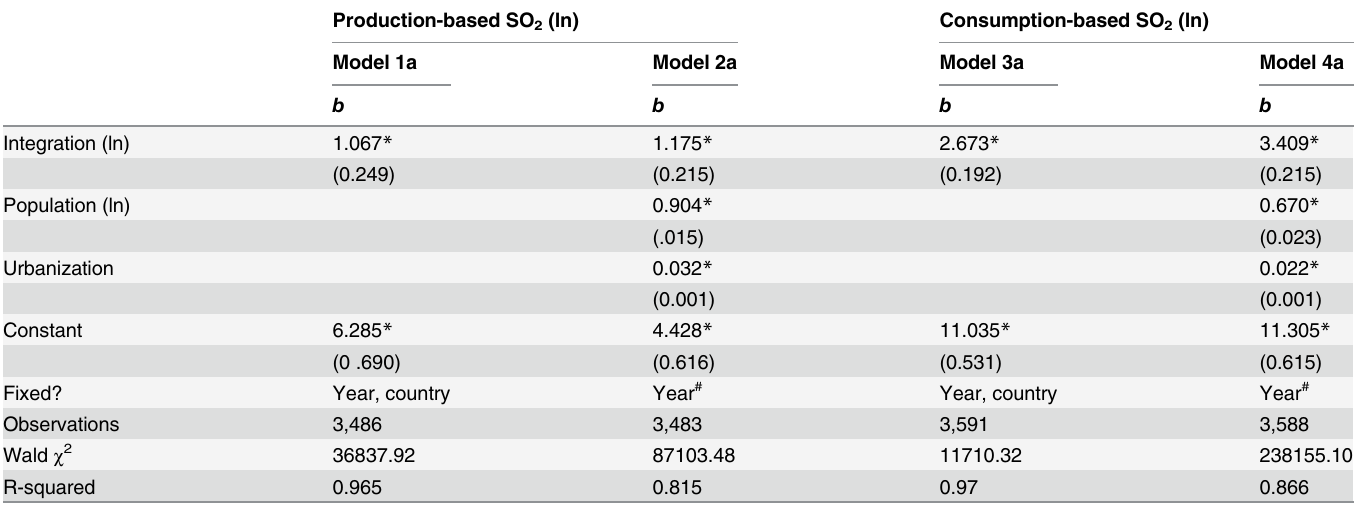
Table 2. Pollution Regressed on Countries ’ Level of Integration.